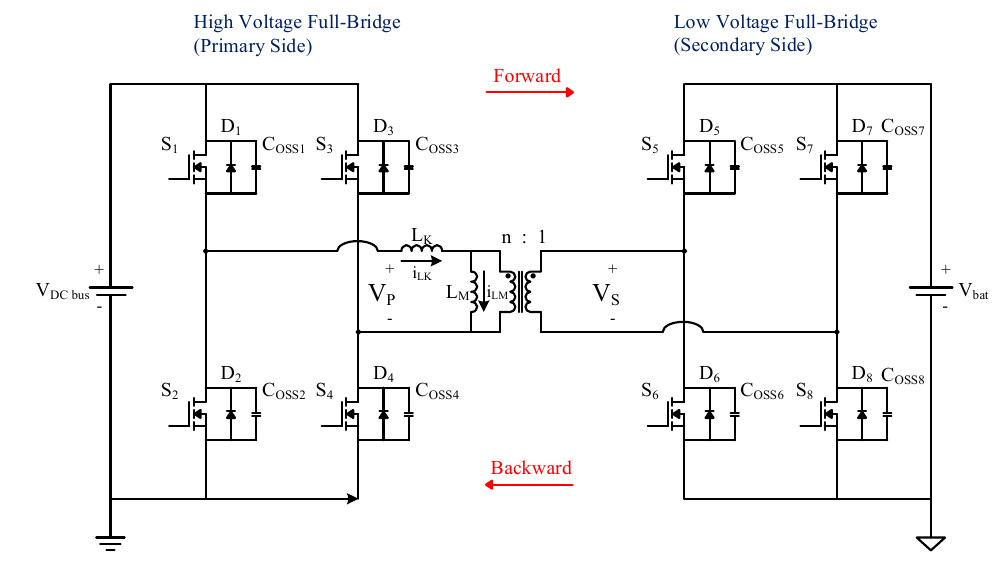
Figure 4. Circuit structure of the DAB converter.